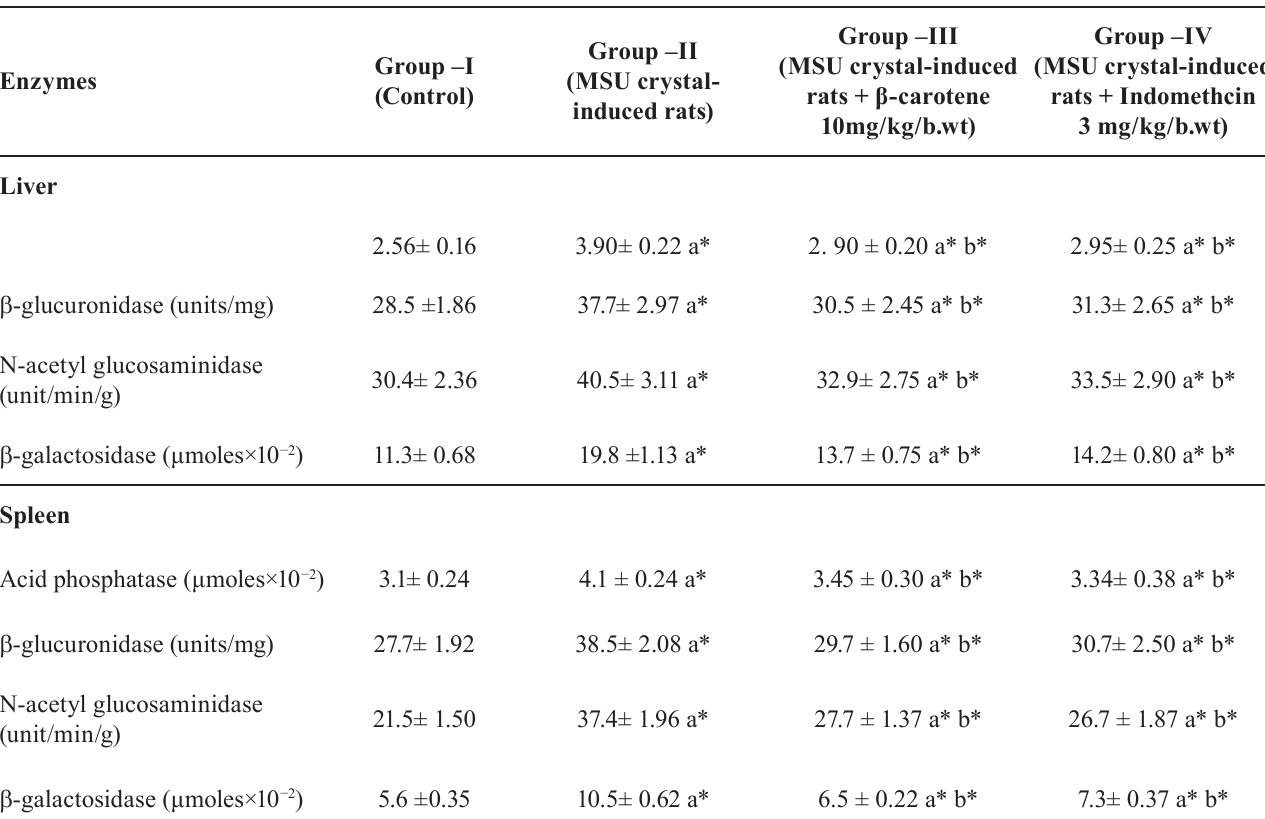
TABLE I - E ffect of β -carotene and Indomethacin on the activity of lysosomal enzymes of liver and spleen of MSU crystal - induced arthritis